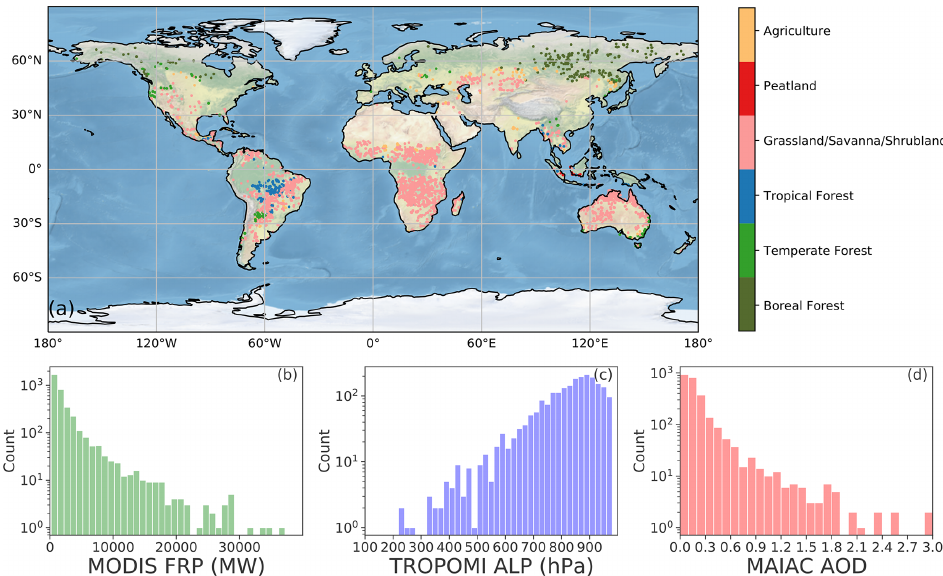
Figure 1. (a) Map of the distribution of selected fire events and corresponding fuel type. Histograms of the distribution of (b) MODIS FRP, (c) TROPOMI ALP, (d) MAIAC AOD for the selected fire events. The number of fire events ( y axis) is on a log